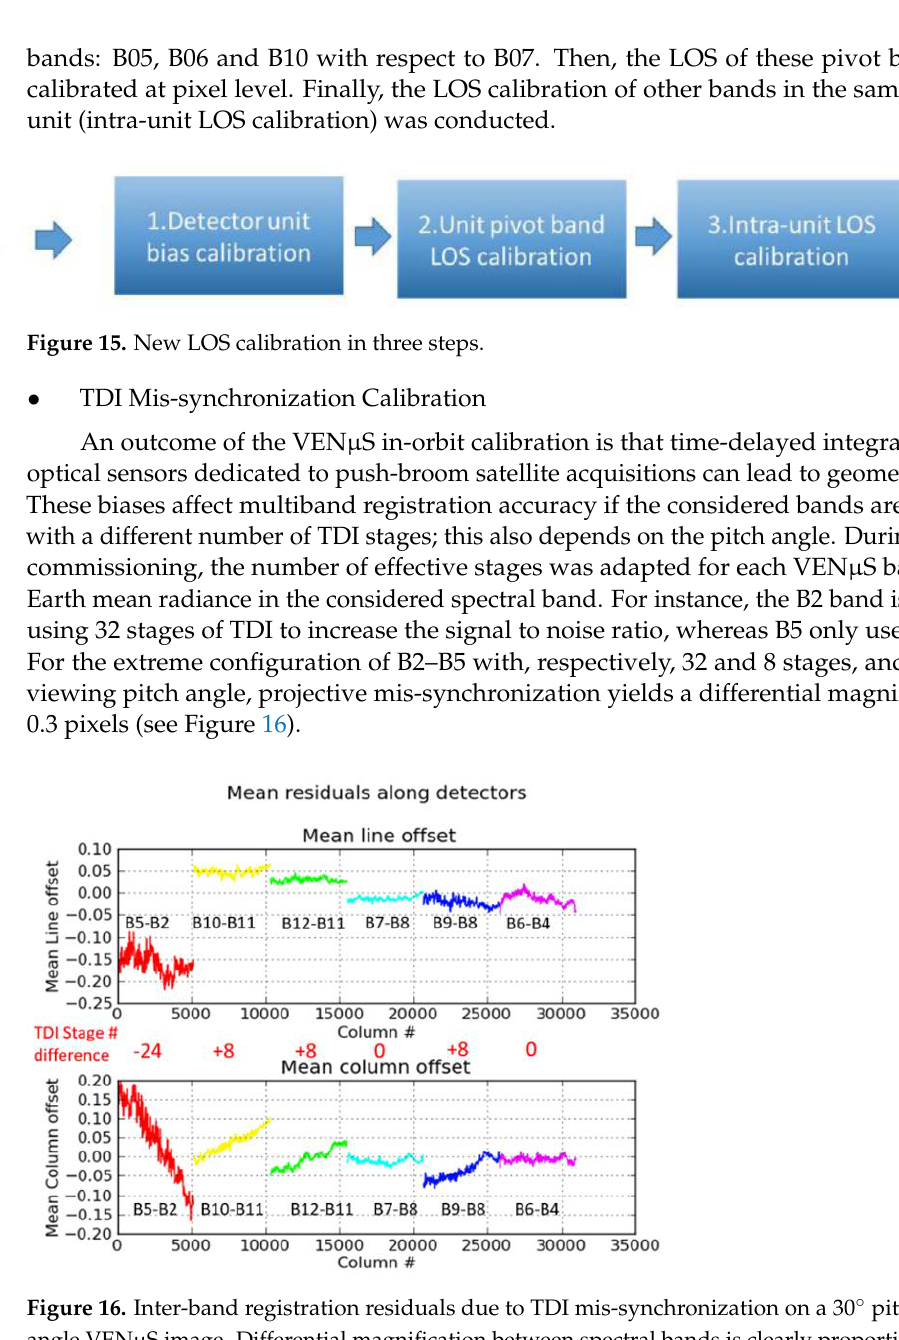
14 of 46 Figure 14. Example of misregistration profiles obtained with 4 spectral bands couples ( a ) along-